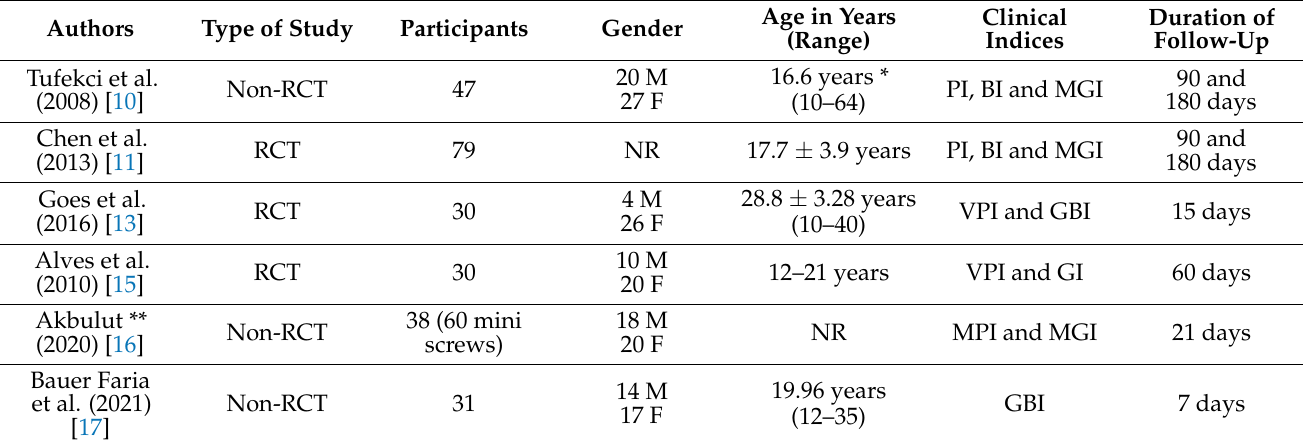
Table 1. General characteristics of the clinical trials assessed.